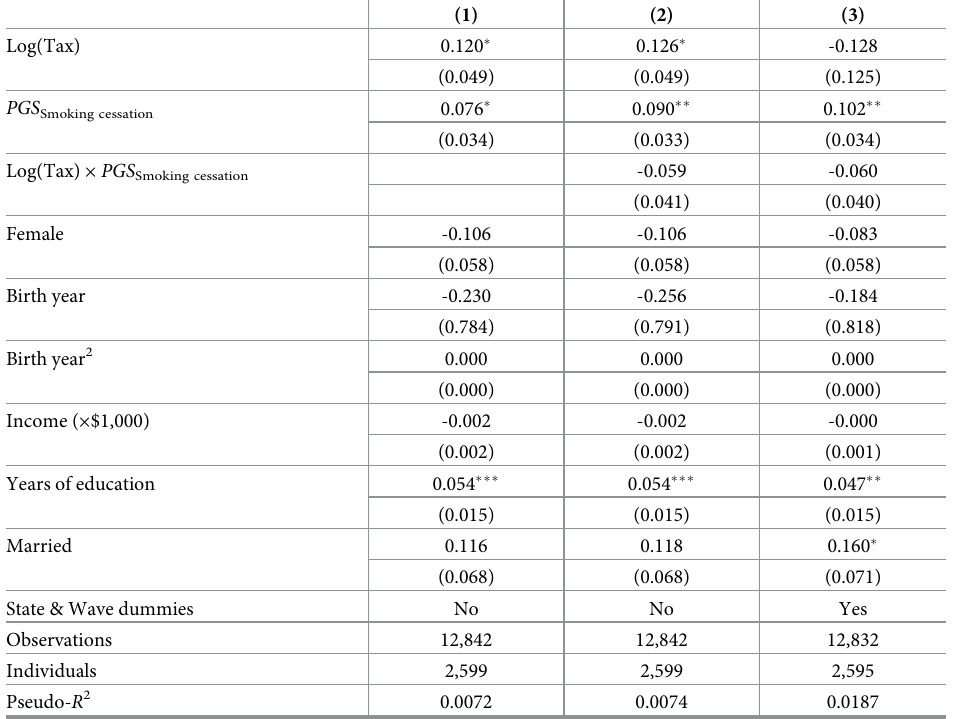
Table 4. Results of the (logit) regressions explaining an individual’s decision to cessate smoking.